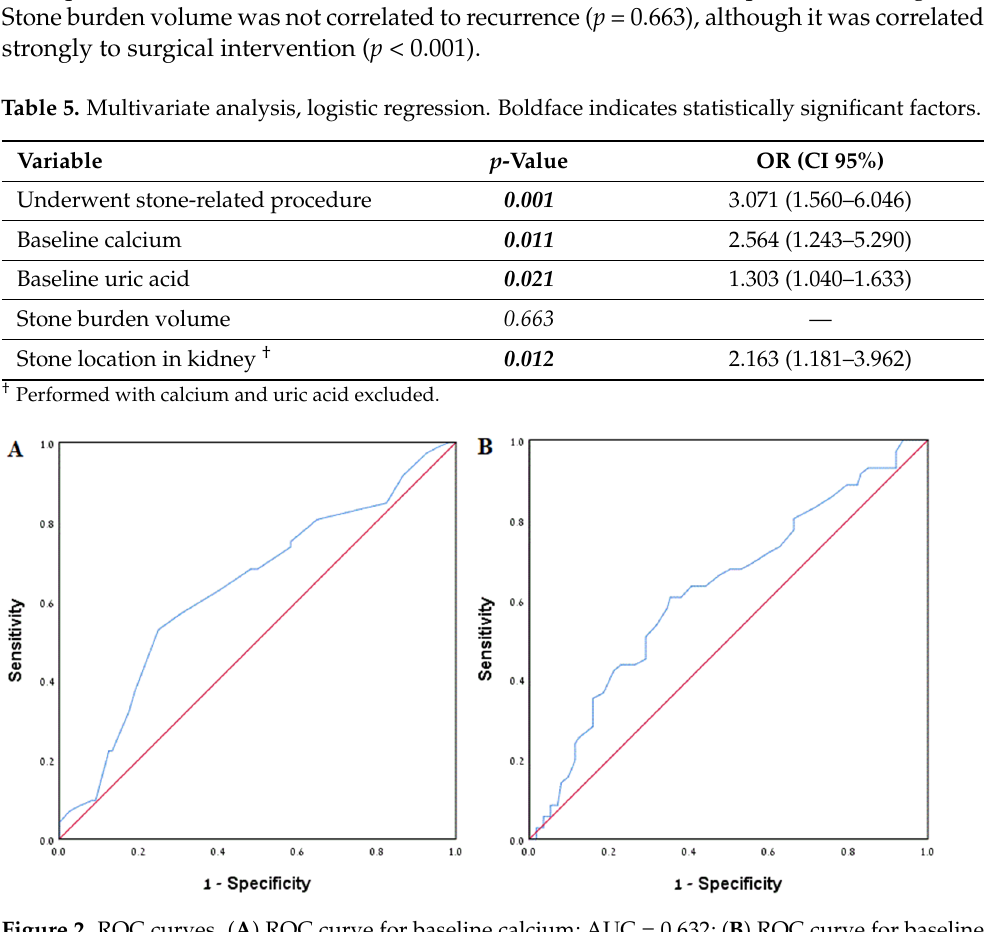
Figure 1. Kaplan–Meier analysis ( A ) stone in the ureter correlated to fewer recurrences, p = 0.019; ( B ) undergoing a procedure correlated to higher recurrence rates, p < 0.001.